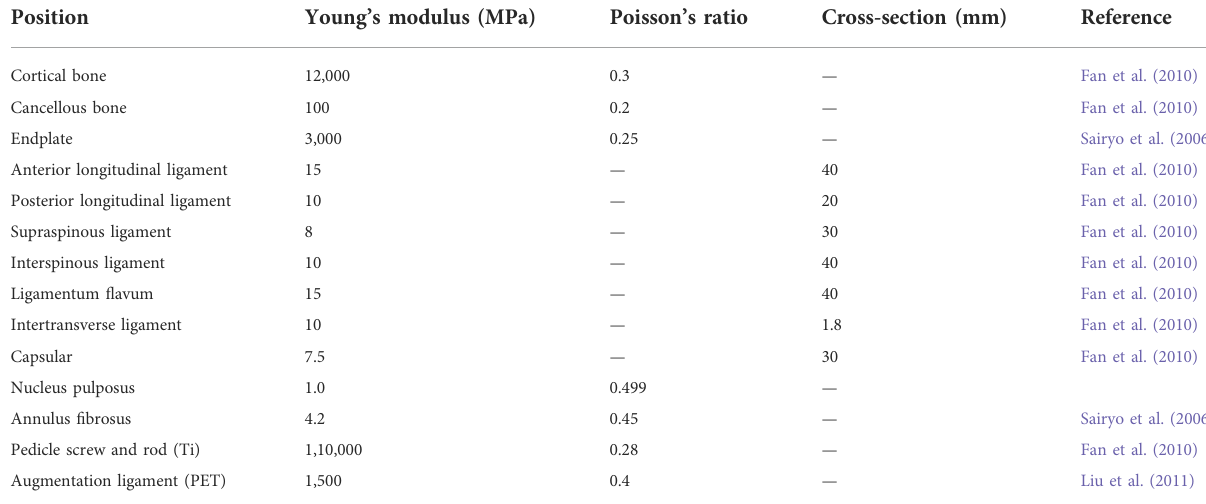
TABLE 1 Summary of material properties in the fi nite element model.